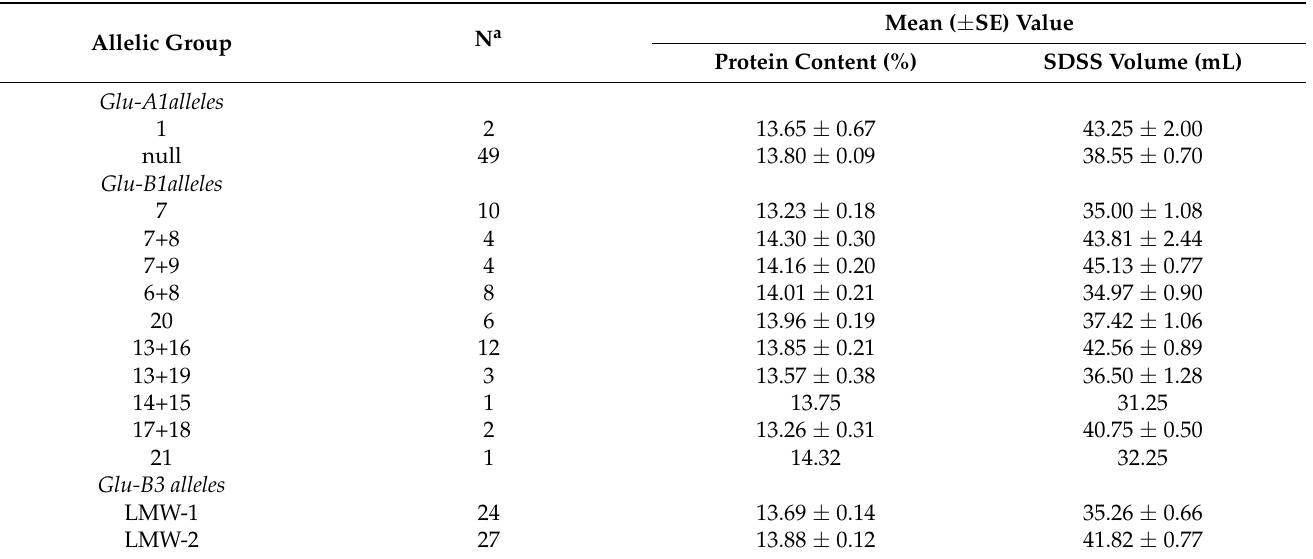
Table 2. Mean values for protein content (%) and SDS sedimentation volumes for HMWGS and